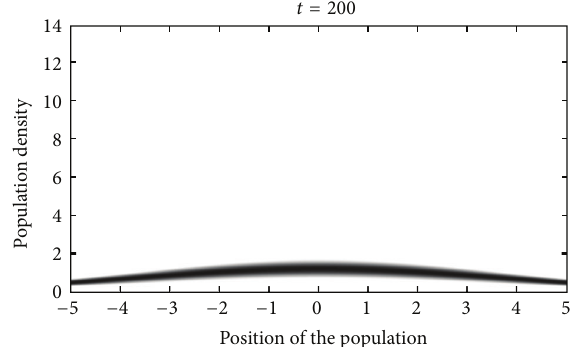
Figure 10: Fuzzy two-dimensional graph of the solution for 𝑡 = 1 involving advection-diffusion-reaction to (𝑎,𝑐) = (0,0) and 𝑏 = 1